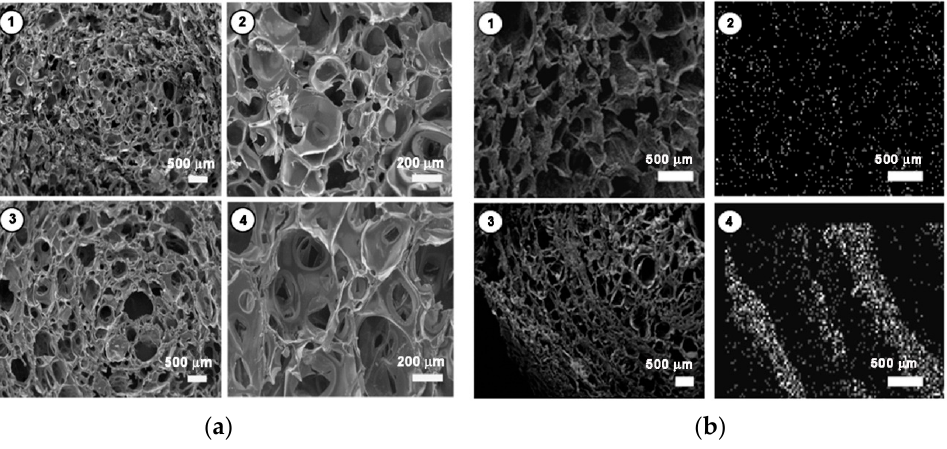
Figure 3. SEM images of samples: ( a ) single-layer curled scaffolds G_0.1 (1, 2) and G_0.15 (3, 4); ( b ) flat layer scaffold S_0.1_Sr-HA (1) and double-layer rolled scaffold G_0.1_Sr-HA/G_0.2 (3) with their EDS map showing the presence of Sr (2 and 4, respectively).